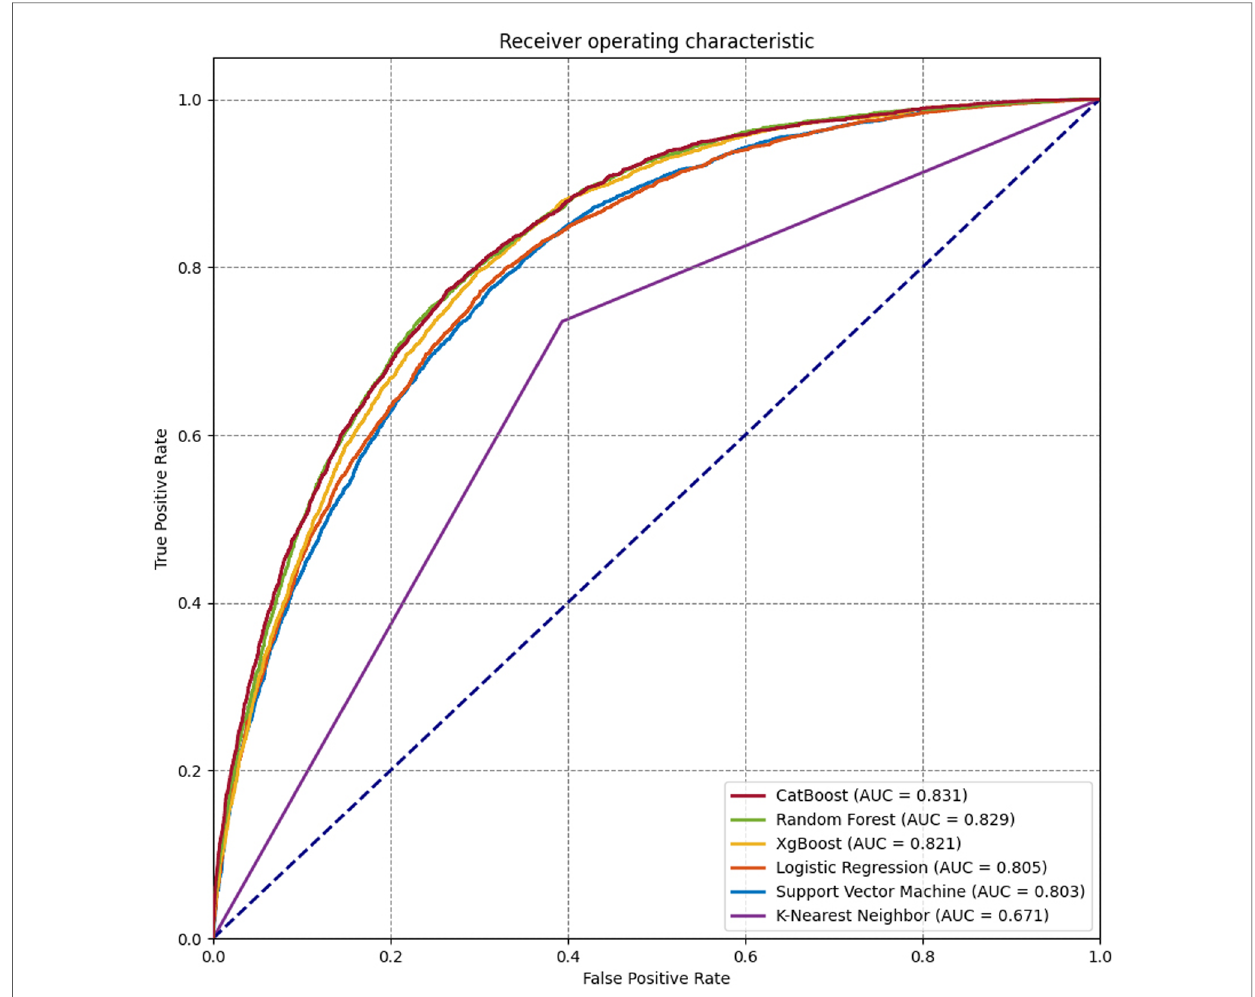
FIGURE 2 Receiver operating characteristic (ROC) curves for the machine learning and logistic regression prediction models.